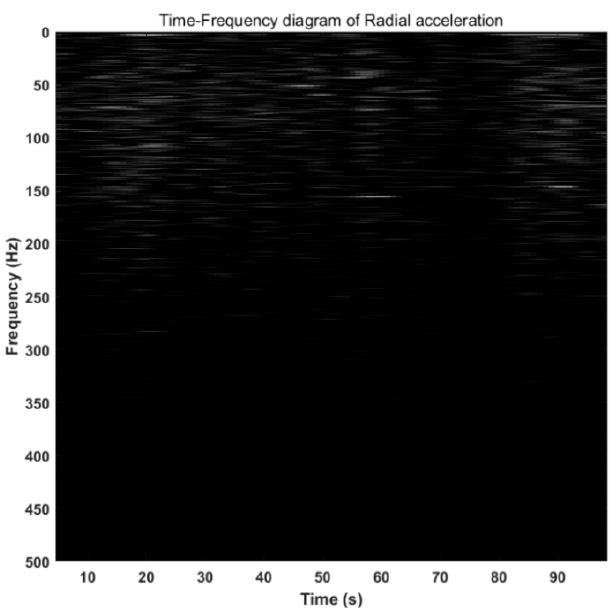
Figure 17. The time-frequency diagram of the radial acceleration of the whirl using light and shade to represent the energy spectrum density.